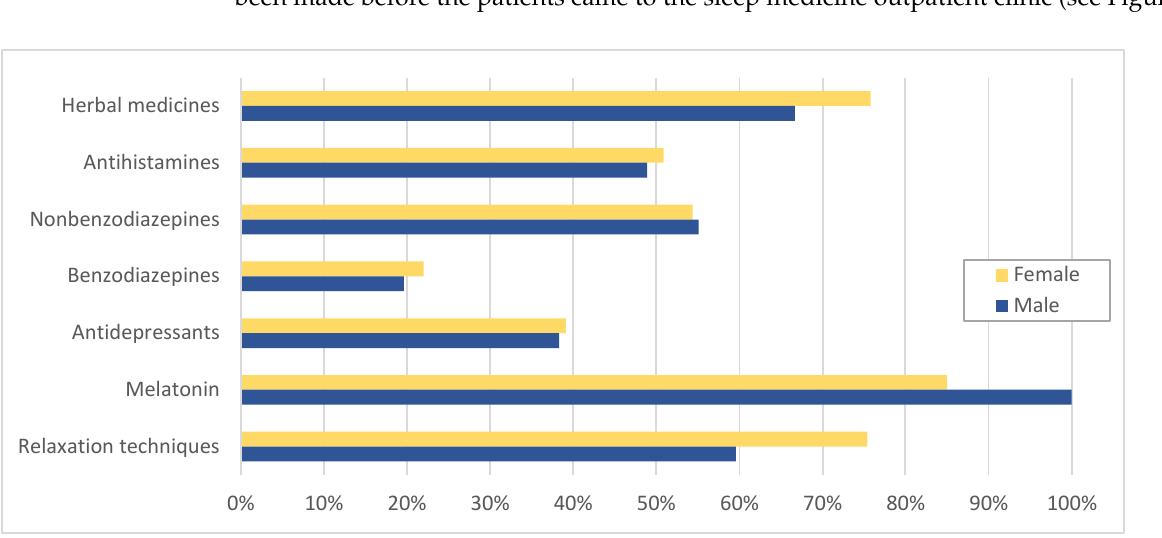
Figure 2. Distribution of SOI (sleep onset insomnia), SMI (sleep maintenance insomnia) and SOI +